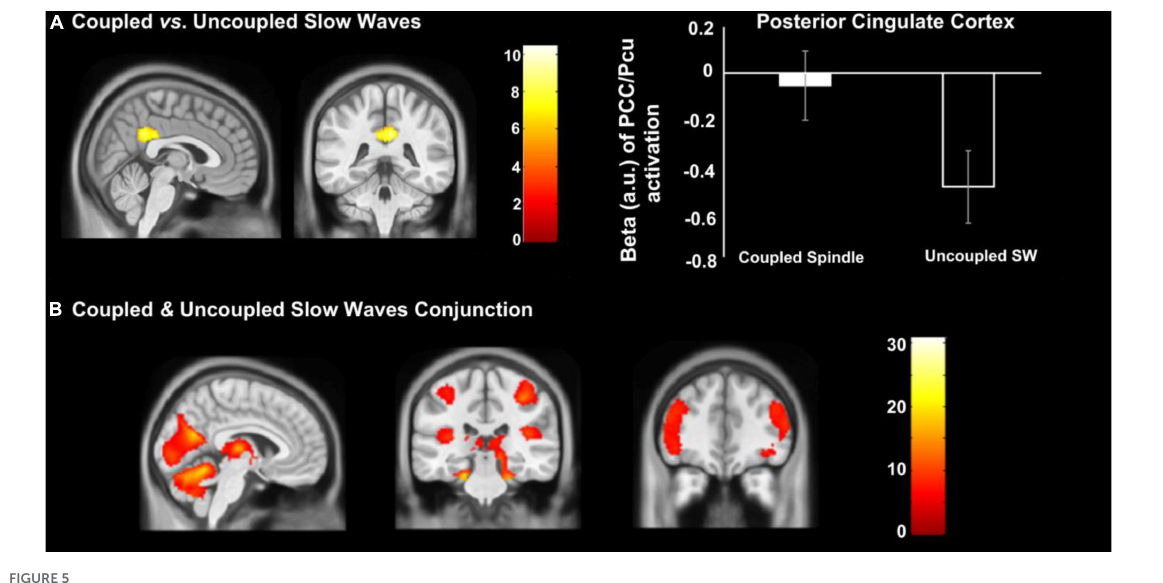
contextual information is processed and eventually